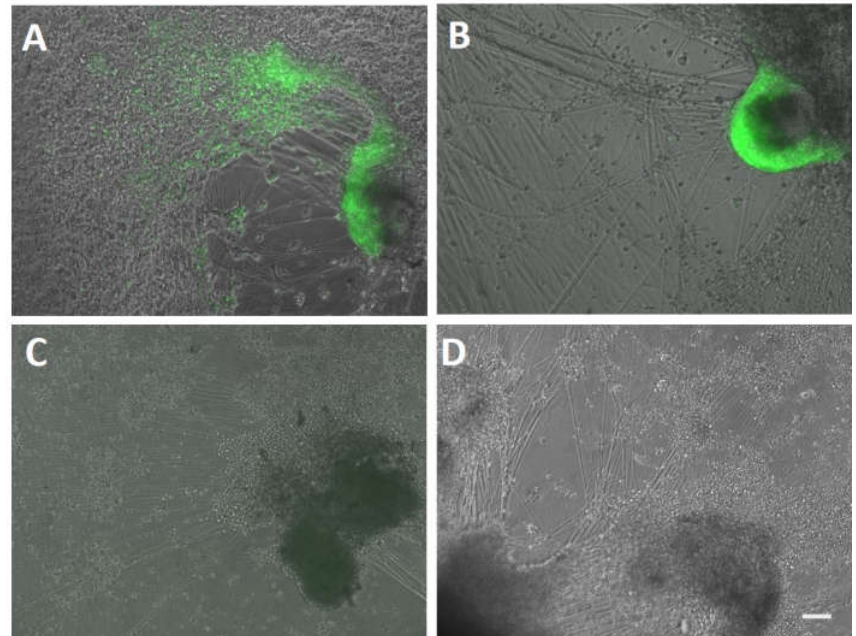
Figure 6. VZVsnc10MUT and VZVsnc12-13DEL are impaired for induced reactivation in hESC-derived neurons. Experimental latency was established in hESC-derived neurons using ACV treat- ment as described in [6] and the Methods. Ten to 15 days after ACV withdrawal there was no spontaneous reactivation as observed by lack of GFP fluorescence indicating production of the ORF23GFP fusion protein. The neurons then received a reactivating stimulus of P3K-inhibitor and PMA as detailed in the methods. Panels show a site of reactivated infection for VZV23GFP ( A ) which were detected in 3 wells of 9 infections performed in parallel to infection with the viruses mutant for VZVsncRNA. ( B ) The only well-containing neurons infected latently with VZVsnc10MUT that reactivated in three experiments including a total of 9 latently infected wells. No reactivation was observed in any of the 9 wells infected with the VZVsnc12-13DEL virus ( C ). ( D ) shows neurons in a mock-infected well receiving the reactivation stimulus. Three independent experiments for each virus VZV23GFP, MZVsnc10MUT, or VZVsnc12-13DEL were performed each including 3 wells in- fected with each virus. Size bar = 100 µm.